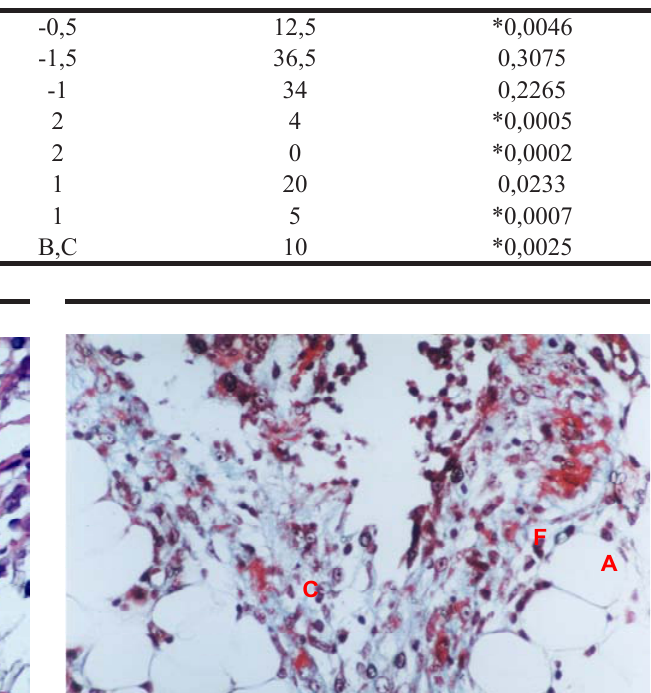
FIGURA 3 – Fotomicrografia da parede colônica de rato do Grupo GJ3. Observa-se inflamação aguda com congestão (C), edema (E) e polimorfonucleares (P).Coloração HE 400X.